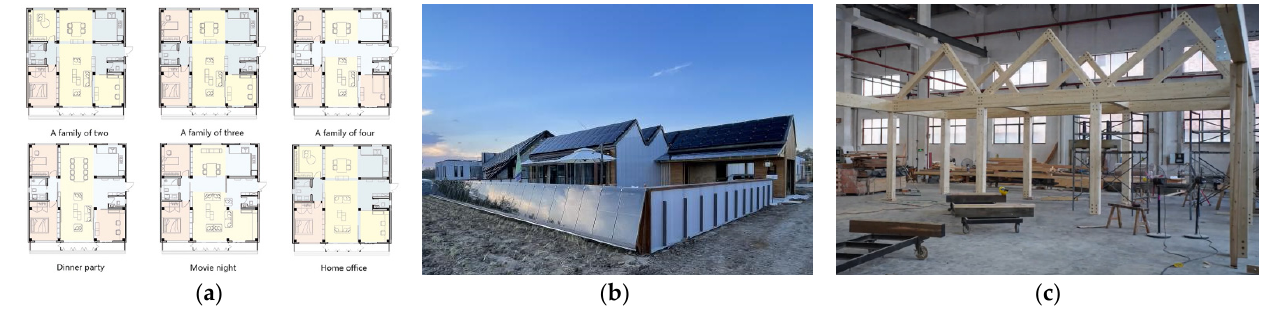
Figure 9. Main results of the Pixel House. ( a ) Changeable modules. ( b ) BIPV and PV fence. ( c ) Pre- fabricated wooden